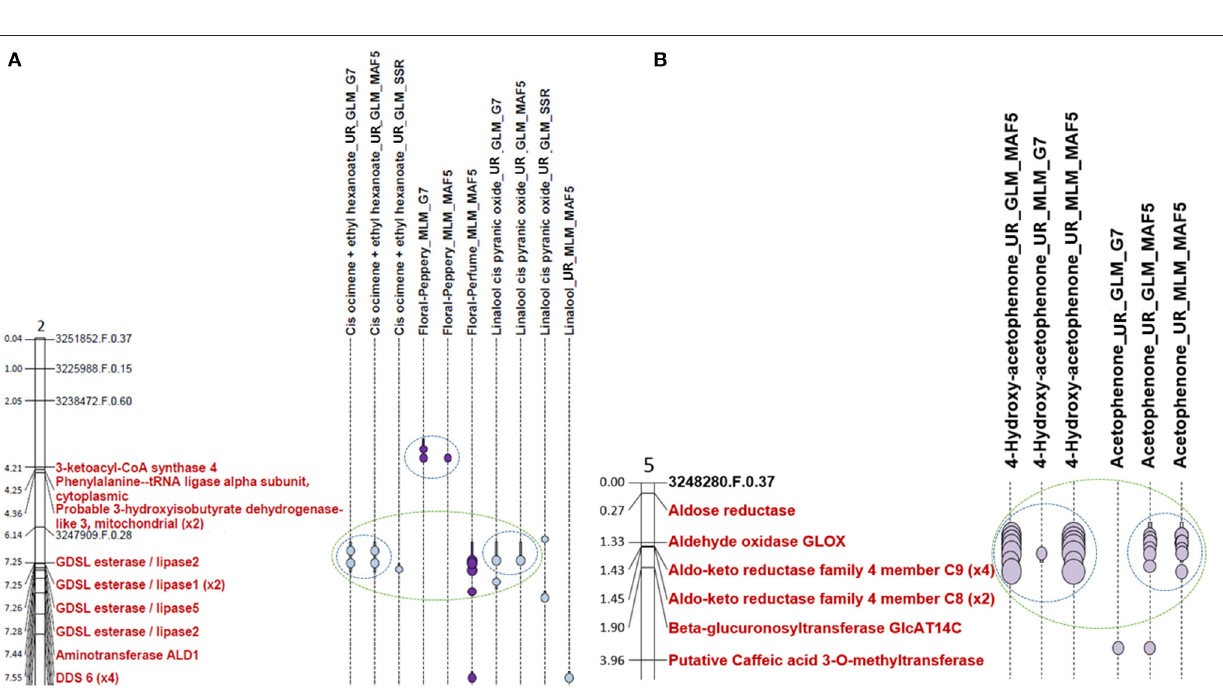
FIGURE 4 | Extract of chromosome 2 map and chromosome 5 map. (A) Extract from the chromosome 2 map representing the associations detected for compounds involved in the monoterpene biosynthetic pathway. (B) Extract from the chromosome 5 map representing the associations detected for compounds involved in the L-phenylalanine degradation pathway. The light blue dots represent the peaks of associations in relation to traits whose beans have not been roasted. The dark purple dots represent the peaks of association in relation to traits whose beans have been roasted. The bars around these points correspond to the confidence intervals of the association zone. Co-locations are represented by a blue circle for the associations co-localised for the same trait and identified by different methods. Co-locations are represented with a green circle for the co-locations between different biochemical compounds. Candidate genes are written in red. One scale unit on the chromosome corresponds to